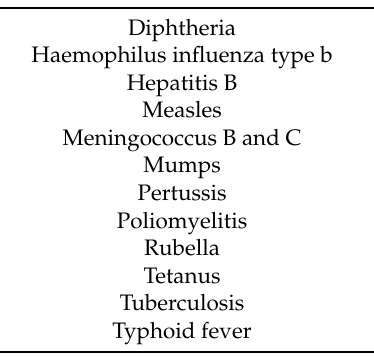
Table 3. Diseases for which Cuban children are